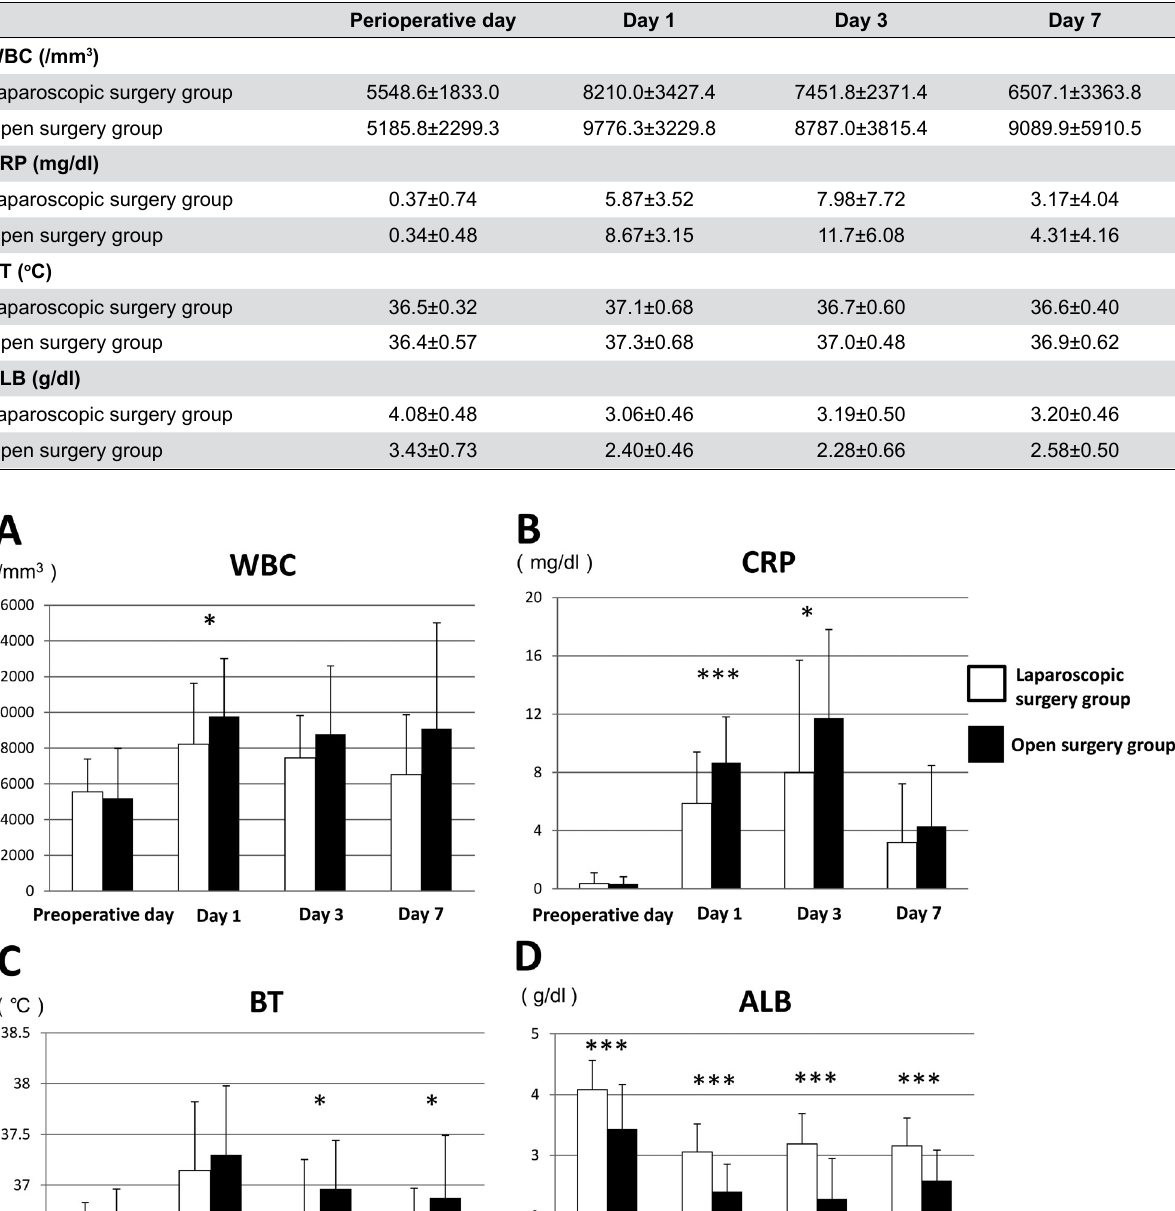
Table 2- Changes in WBC count, CRP level, BT, and ALB